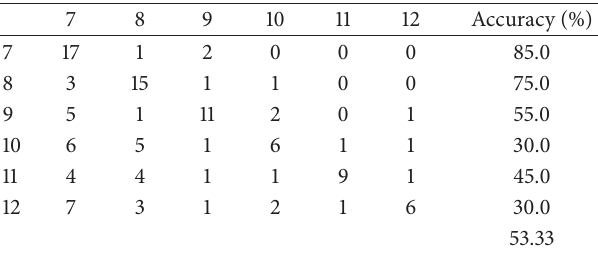
Table 4: Confusion matrix of the proposed age estimation method based on 6 age classes.